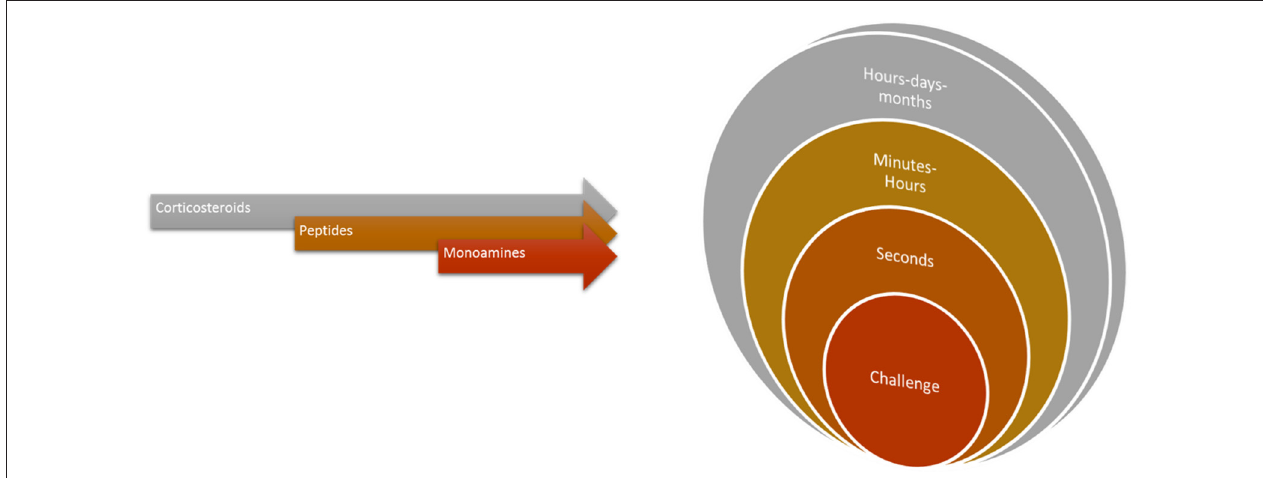
FIGURE 6 | The temporal profiles of the orchestrated physiological response demanded of cleaning behavior. For instance, receptor activation by monoamines, peptides or corticosteroids can have rapid stimulation (or blockage) within seconds to minutes (synaptic or membrane located effects) to genomic or more structural effects happening in wider temporal